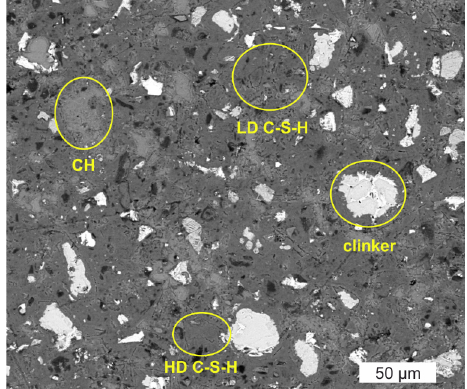
Figure 1. Typical SEM-BSE image of cement paste showing individual